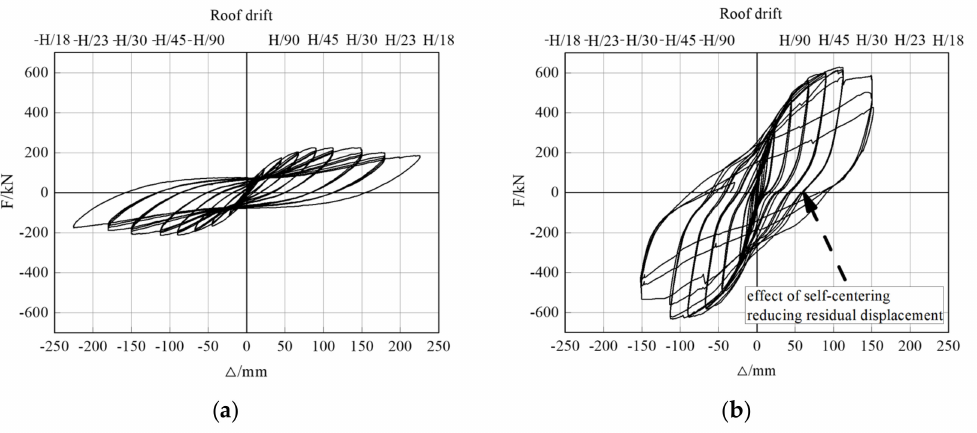
Figure 6. Hysteresis curves of specimens. ( a ) CF structure; ( b ) PFRW